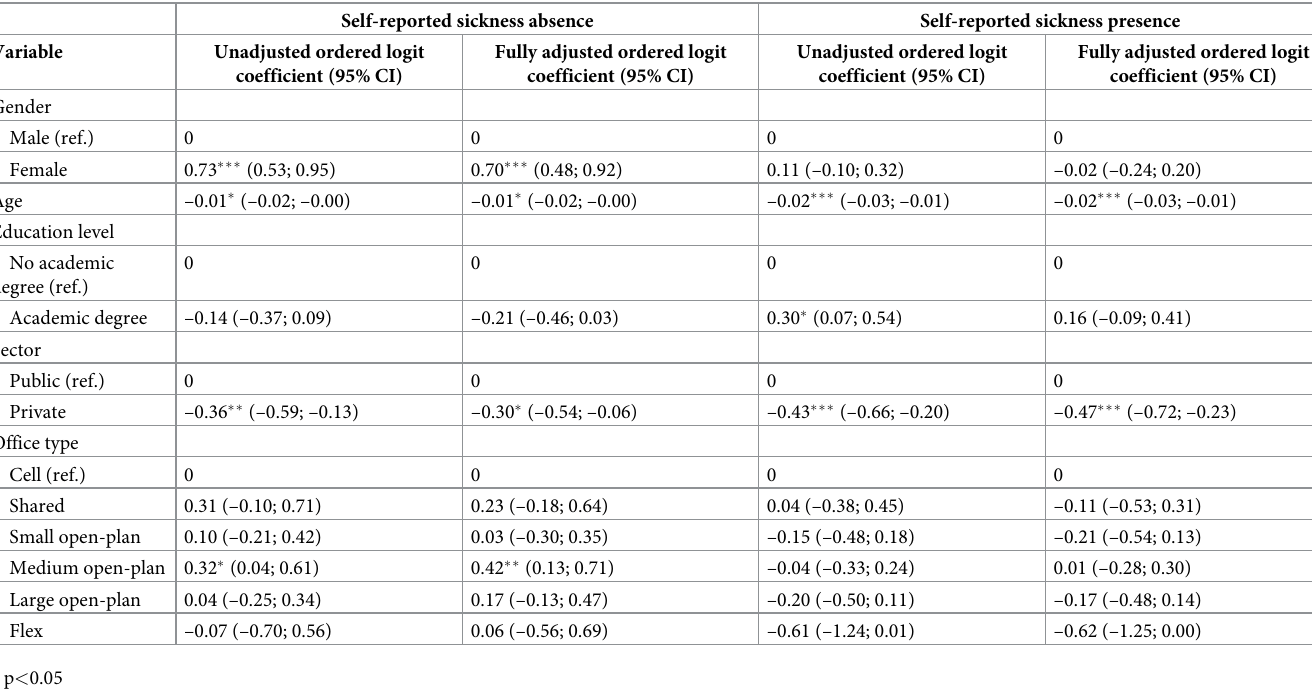
Table 7. Associations of office type with self-reported sickness absence and self-reported sickness presence: Results from ordered logistic regressions (n =